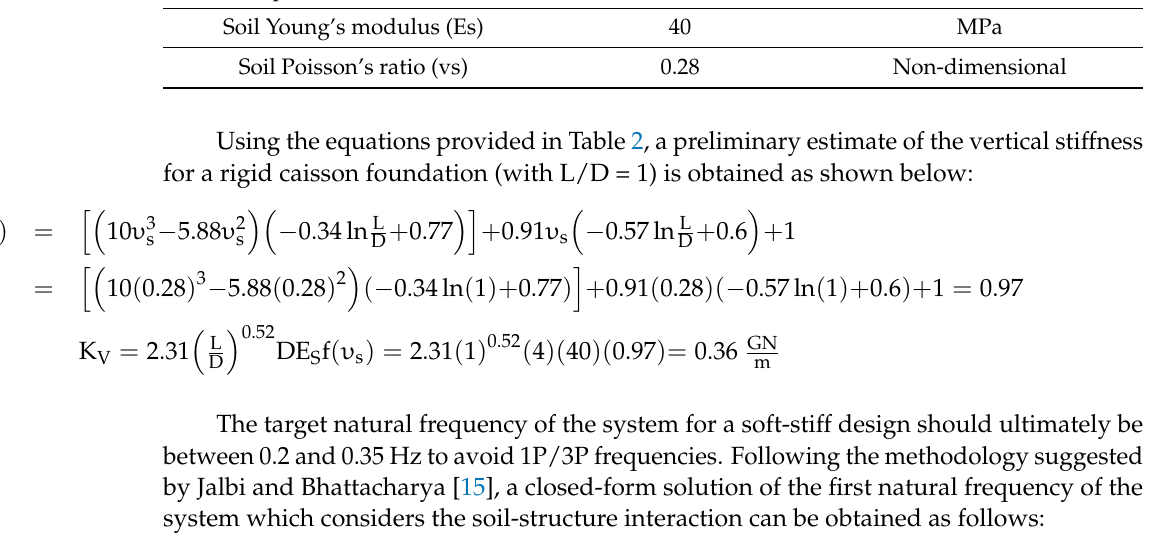
Table 5. Foundation details for the example problem. Parameter Value Unit Foundation depth (L) 4 m Foundation diameter (D) 4 m Depth to bed rock (H) 50 m Soil Young’s modulus (Es) 40 MPa Soil Poisson’s ratio (vs) 0.28